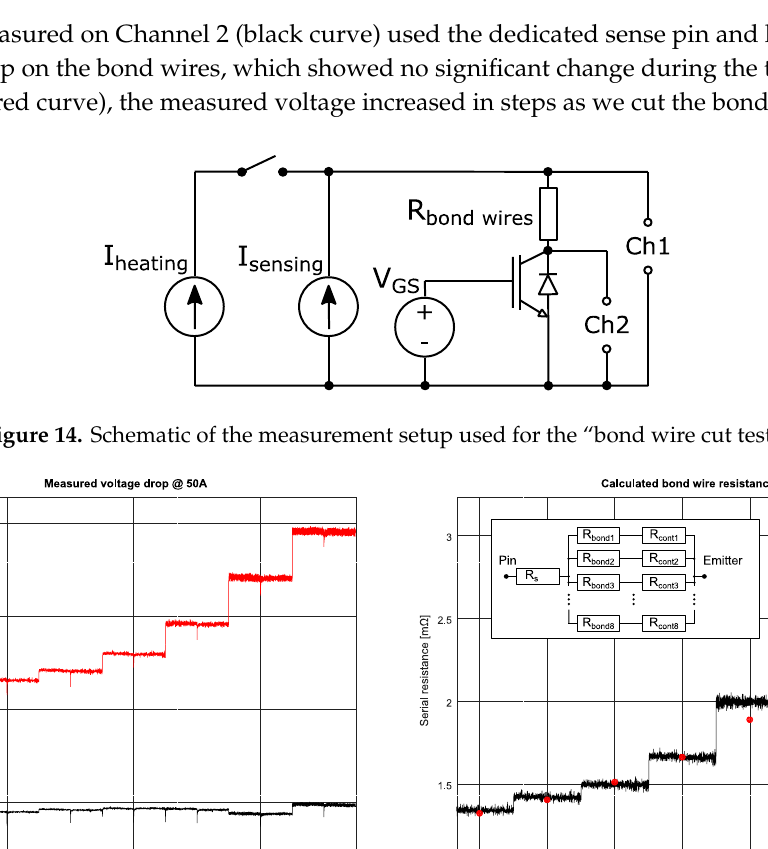
Figure 14. Schematic of the measurement setup used for the “bond wire cut test”.